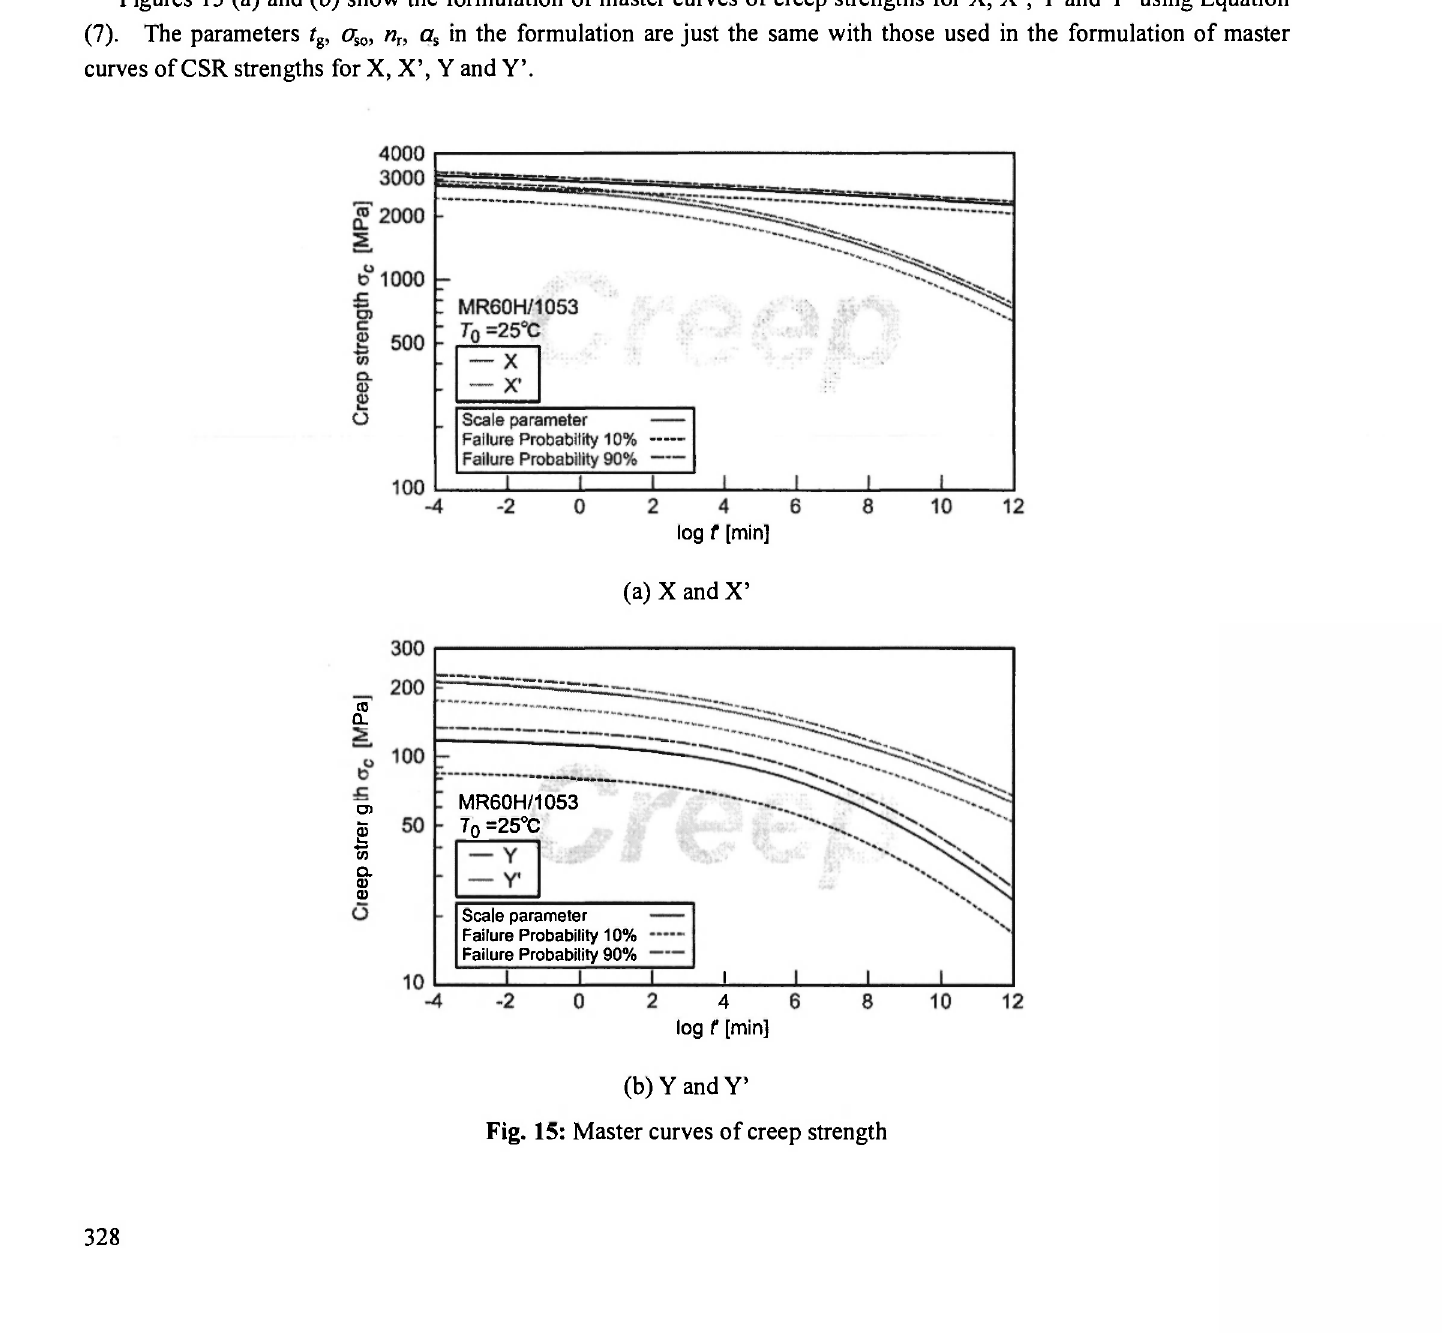
Fig. 15: Master curves of creep